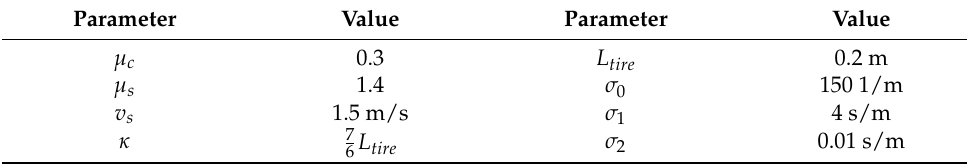
Table 1. LuGre dynamic friction model parameters.